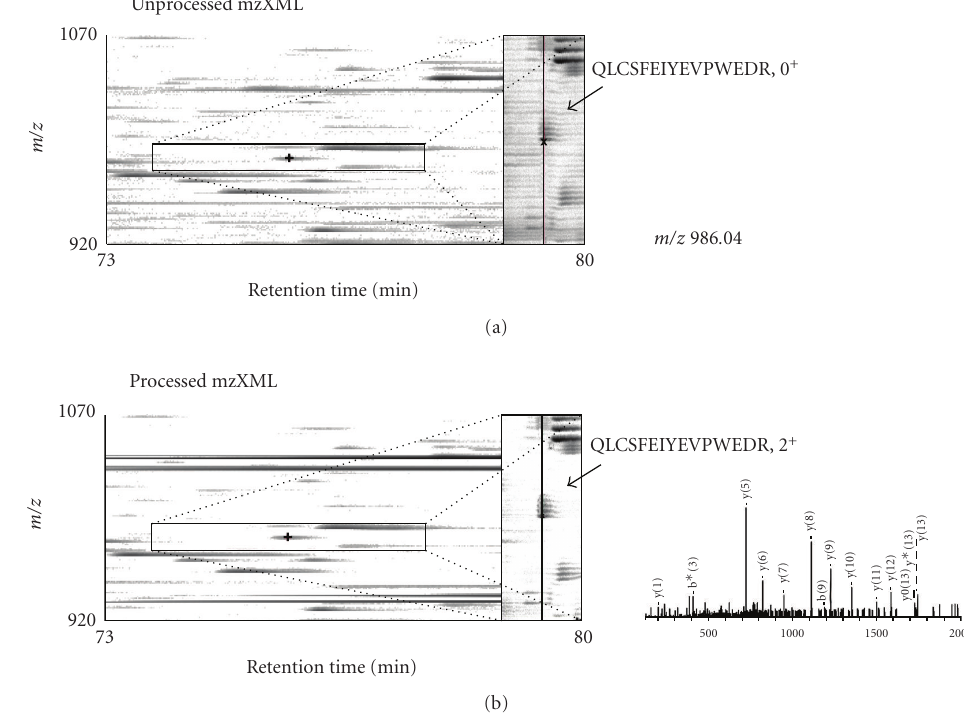
Figure 4: Details of unprocessed and processed LC-MS maps. Despite its high intensity, the highlighted doubly charged peptide QLCSFEIYEVPWEDR (m/z 986.04) was not assigned a charge in the original map, because some of its isotopes were altered by the chemical